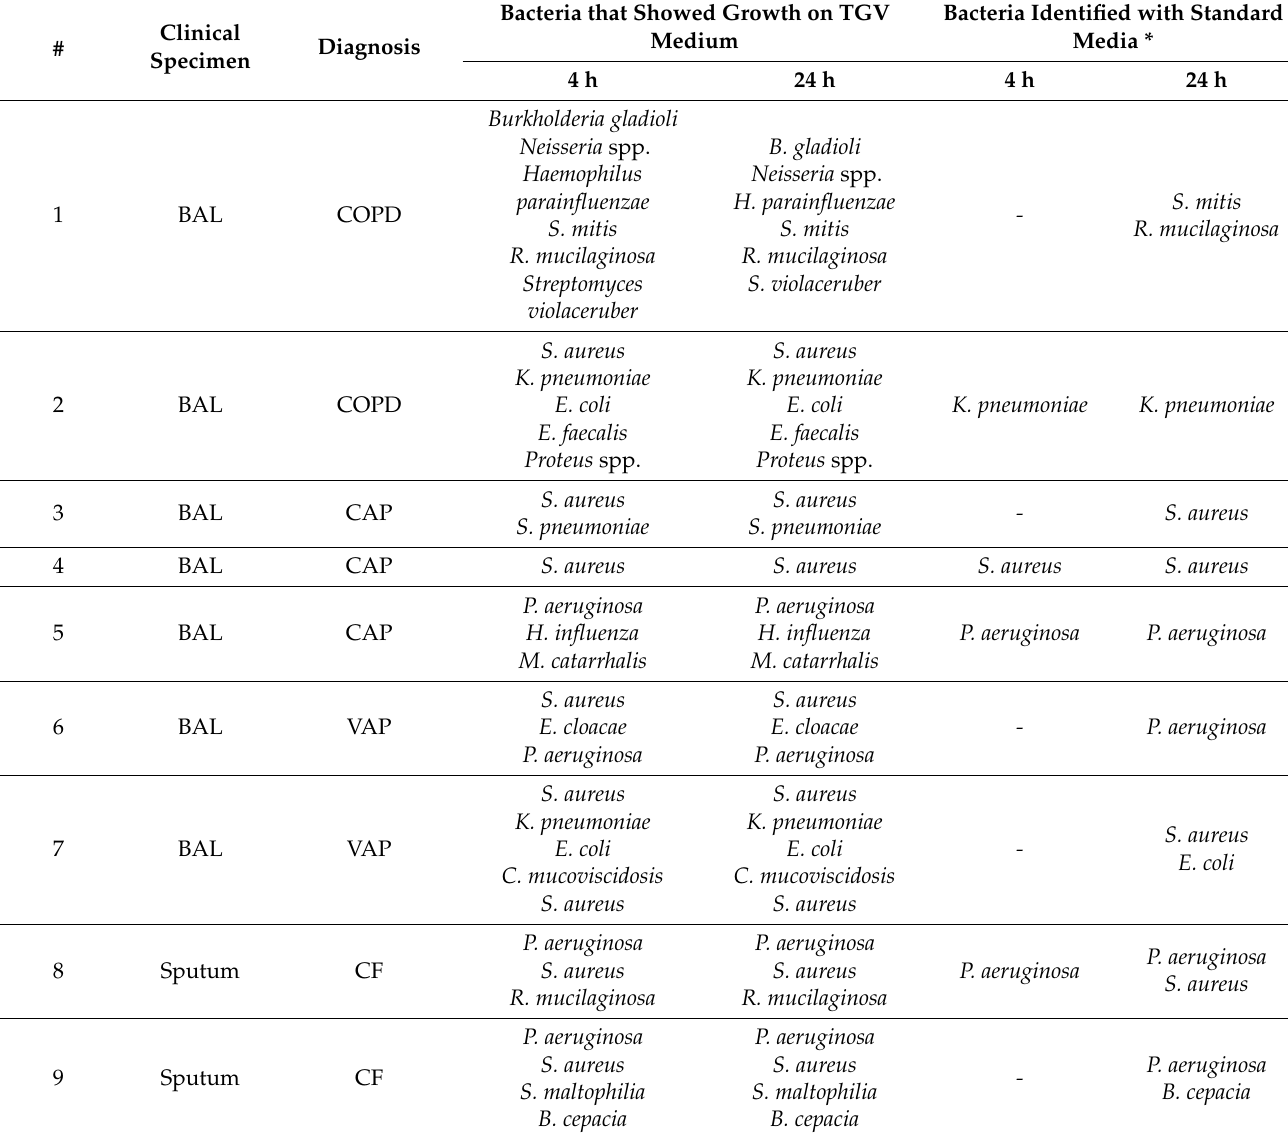
Table 1. Comparison of diversity values of bacteria grown on AtbFinder and standard media for 4 and 24 h. Clinical #